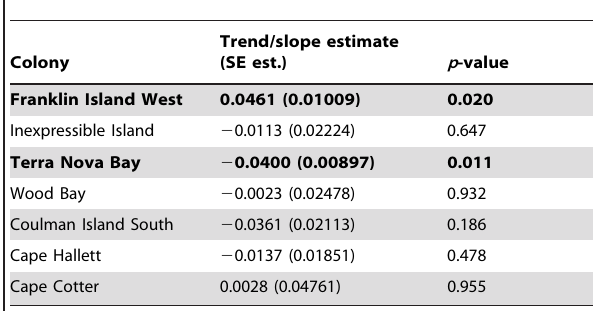
Table 3. Summary of linear trend models for northern Victoria Land colony counts (log e -transformed) for the years 1981–2000.